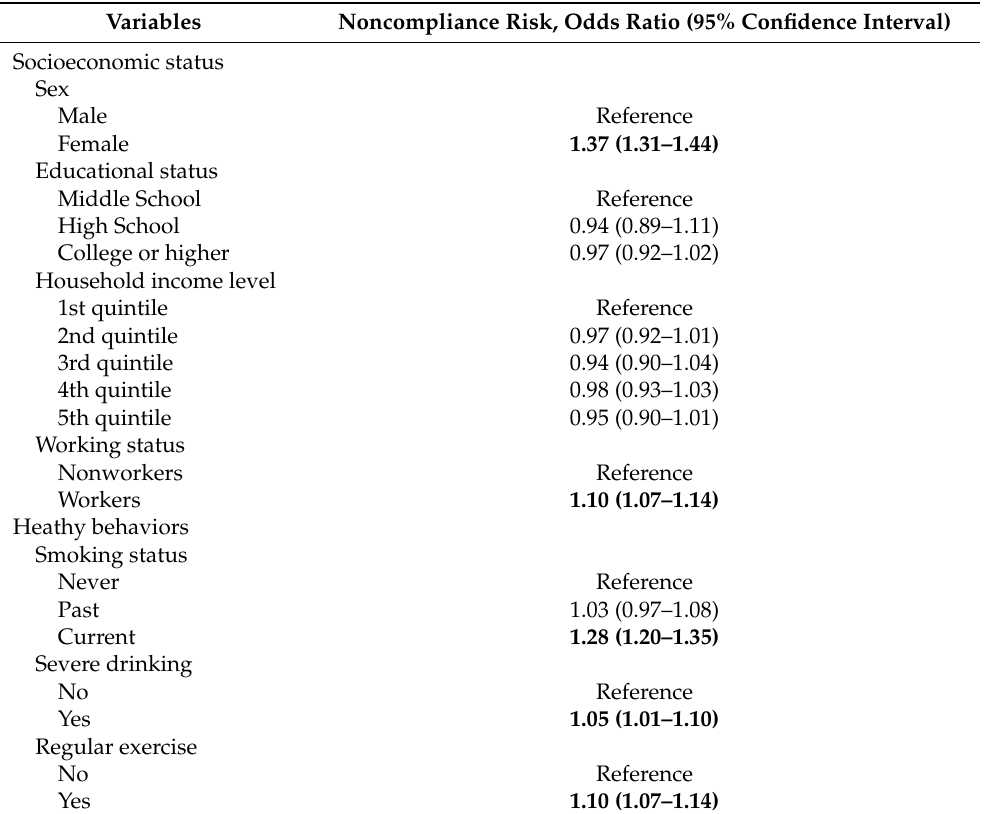
Table 2. Results of the generalized estimating equation analyzing the risk of noncompliance of medication